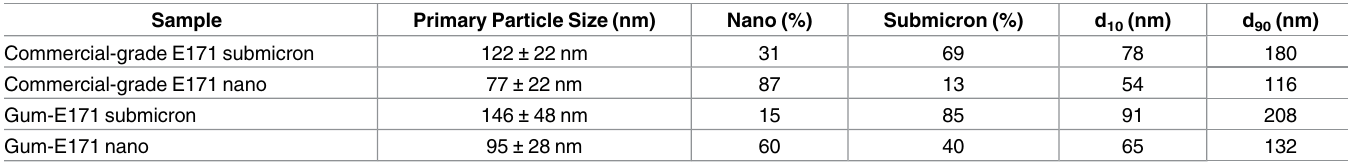
Table 2. Primary particle analysis using TEM for commercial-grade E171 and gum-E171 nano- and submicron-enriched fractions.